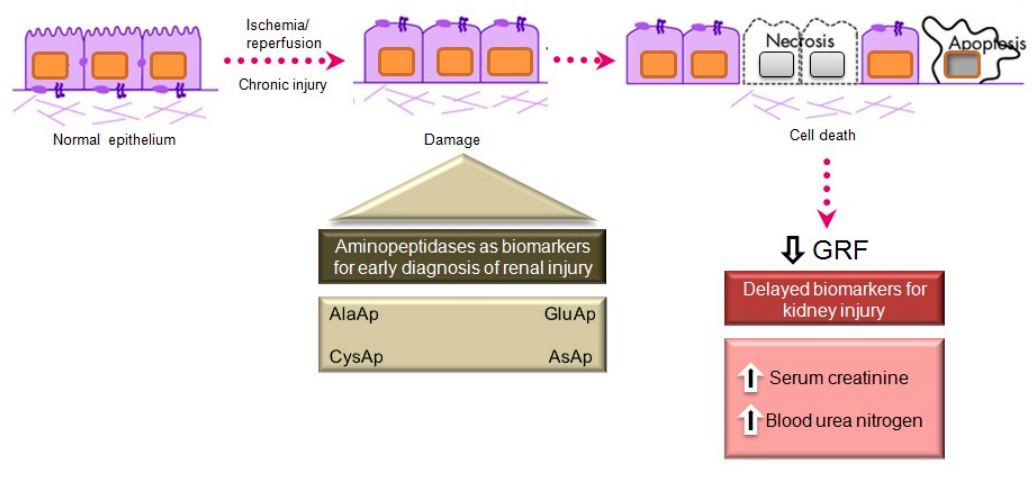
Figure 4. Main aminopeptidases studied as biomarkers of acute and chronic kidney injury.